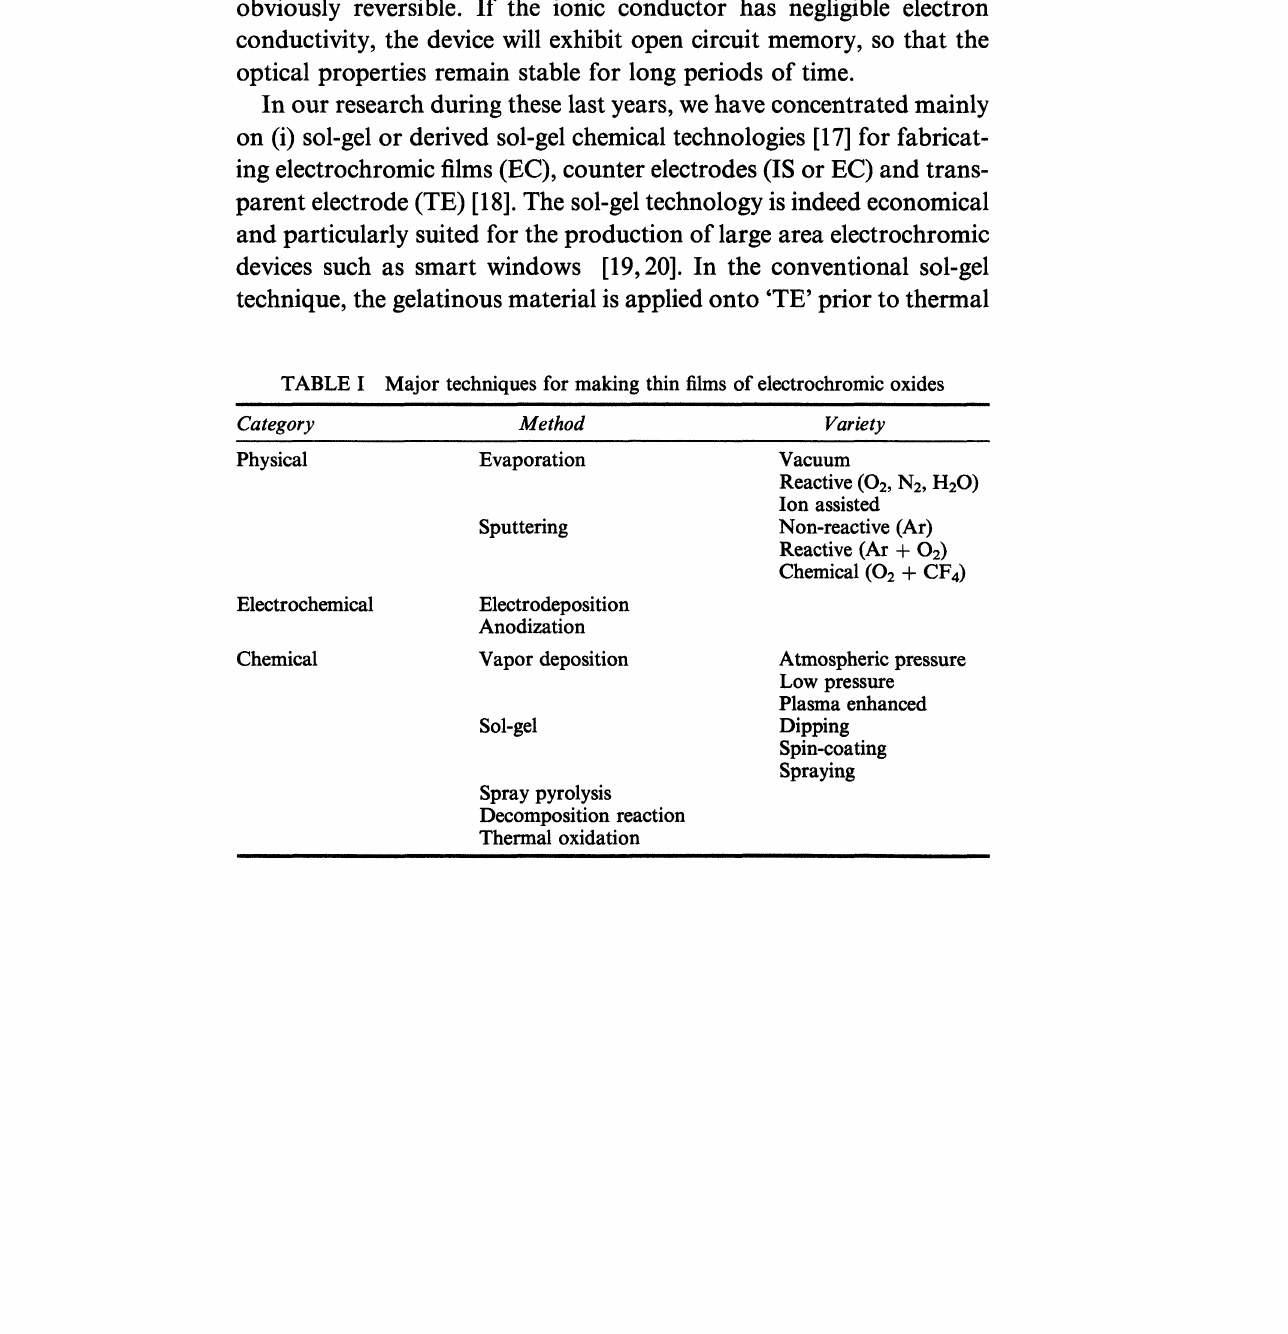
Major techniques for making thin films of electrochromic oxides